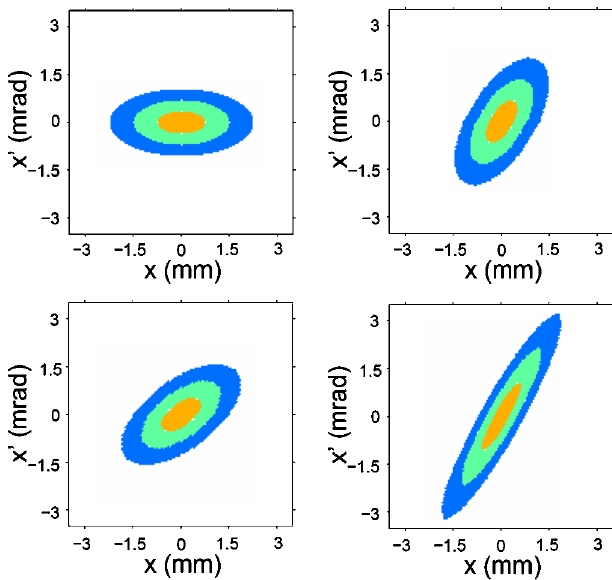
FIG. 1. (Color) Schematic show of phase space evolution within the frame of affine transformation. The colors blue, green, and yellow indicate increasing